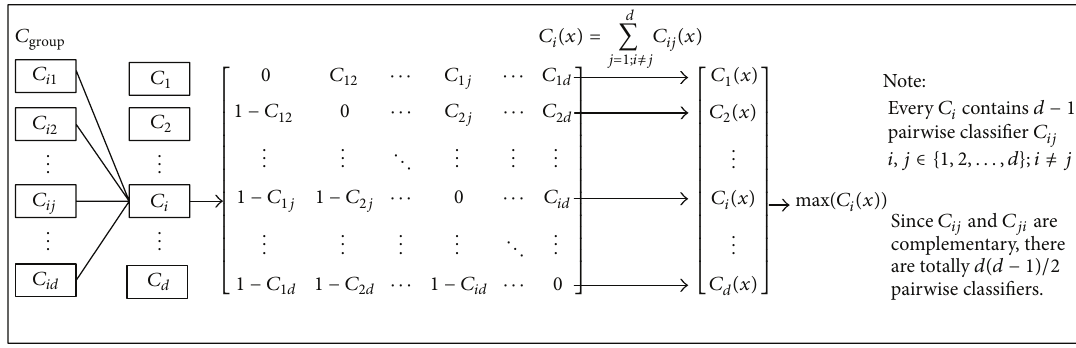
Figure 3: One-versus-one strategy of multiclass classification.